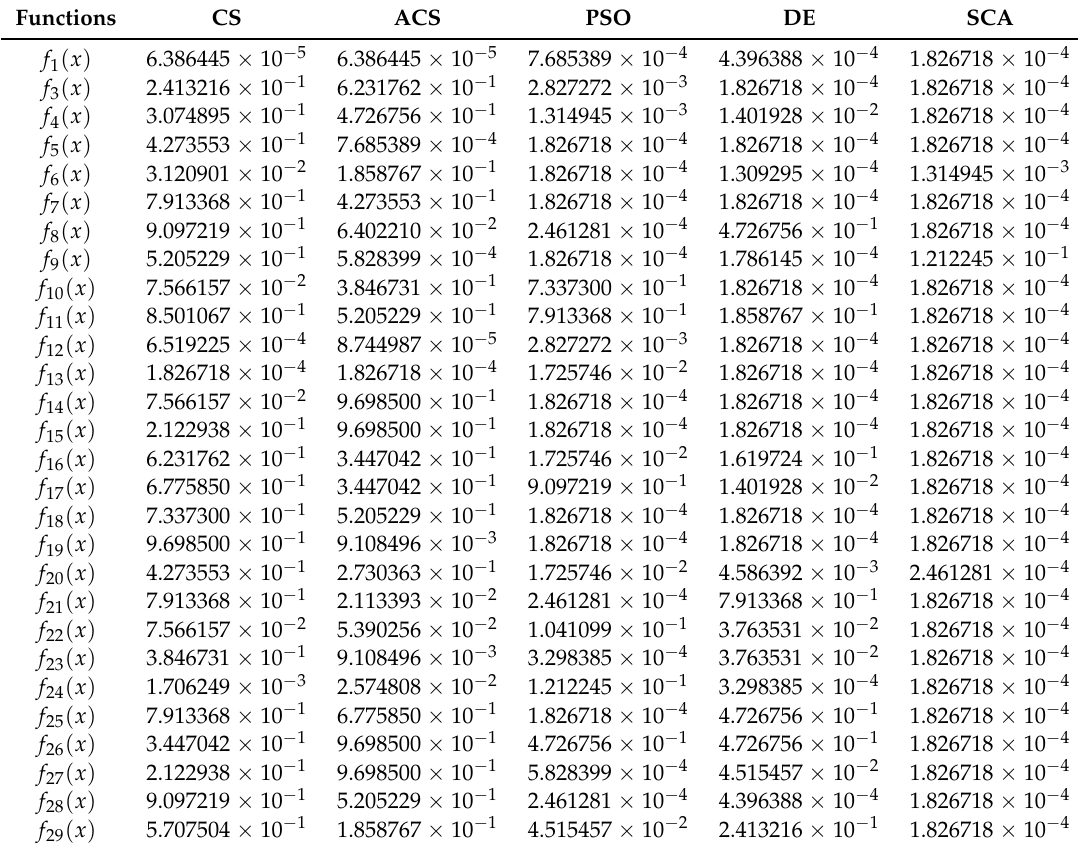
Table 4. Compared with the proposed icCS, the overall performance of each algorithm is measured at a significant level α = 0.05 under the Wilcoxon’s signed rank